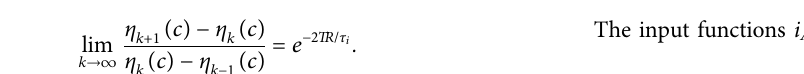
FIGURE 6 | Numerical analysis of switching states. (A) Time histories of switching states W 1, k for k (cid:2) 2, 3, 4, 5 computed using forward numerical integration of system (12) at different values of η . (B) Codimension-1 bifurcation diagram of the stable states in panel A at varying parameter η . Red circles indicate failure of convergenceofthenumericalcontinuation.Modelparametersinbothpanelsare a (cid:2) 0.6, b (cid:2) 2, c (cid:2) 2, PR (cid:2) 10, α (cid:2) 150, β (cid:2) 20, θ x (cid:2) 0.5, τ i (cid:2) 0.3, τ (cid:2) 0.001, θ (cid:2) 0.5and TD (cid:2)